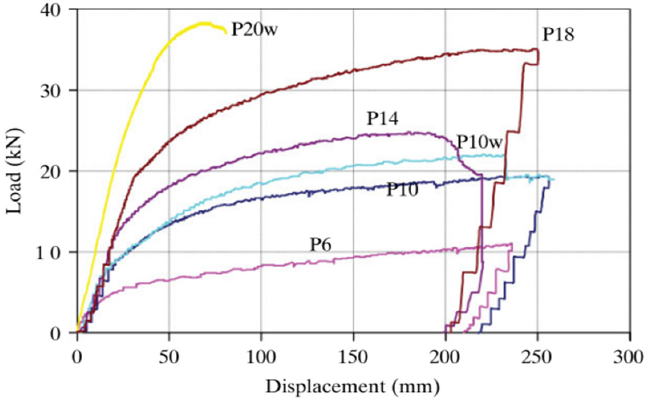
Figure 19. Load–displacement experimental curves for each specimen, adapted from [53].